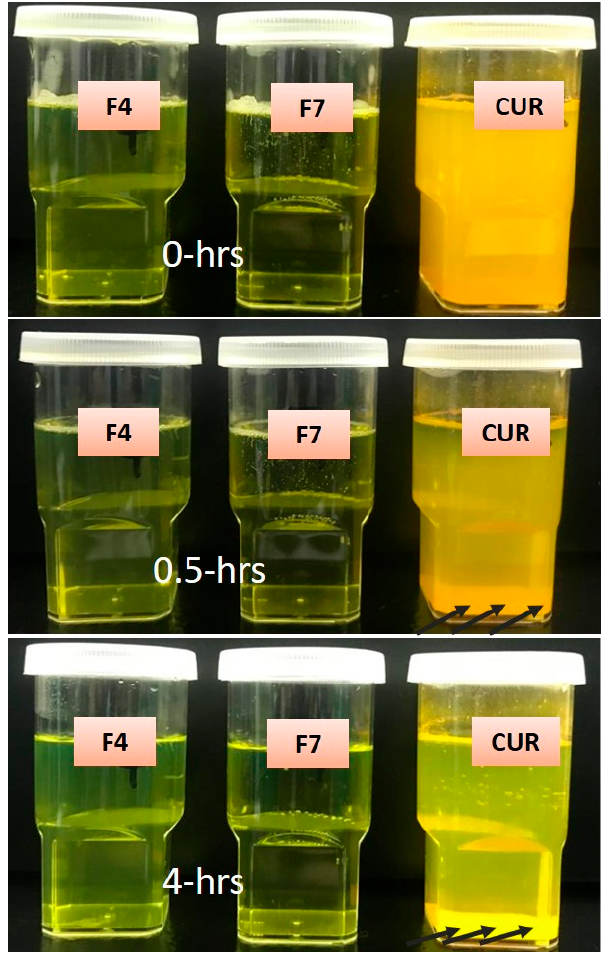
Figure 5. Aqueous dispersion shows the physical stability of formulation F4 (BSO/I988/KolliphorEL (35/15/50 % w / w )), F7 (HCO-30), and pure CUR powder at 0, 0.5, and 4 h periods at room temperature. The arrow shows the precipitation of CUR powder. Table 3. Time-dependent stability studies showing the droplet size (upon dispersion) and drug recovery after three months at room temperature. CUR dissolved in the formulations is equivalent to 80% of equilibrium solubility.